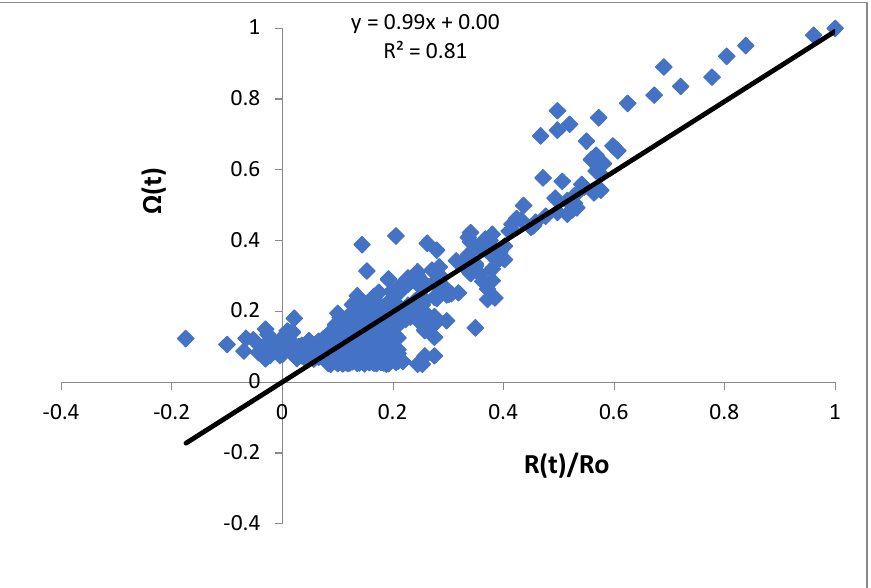
Figure 7. A comparison of the experimentally estimated Ω(t) function with the calculated values R(t) /Ro for the post-seismic relaxation period after the Lefkas main event for τ min ≈ 3.5 days and τ max ≈ 350 days, respectively (see text).